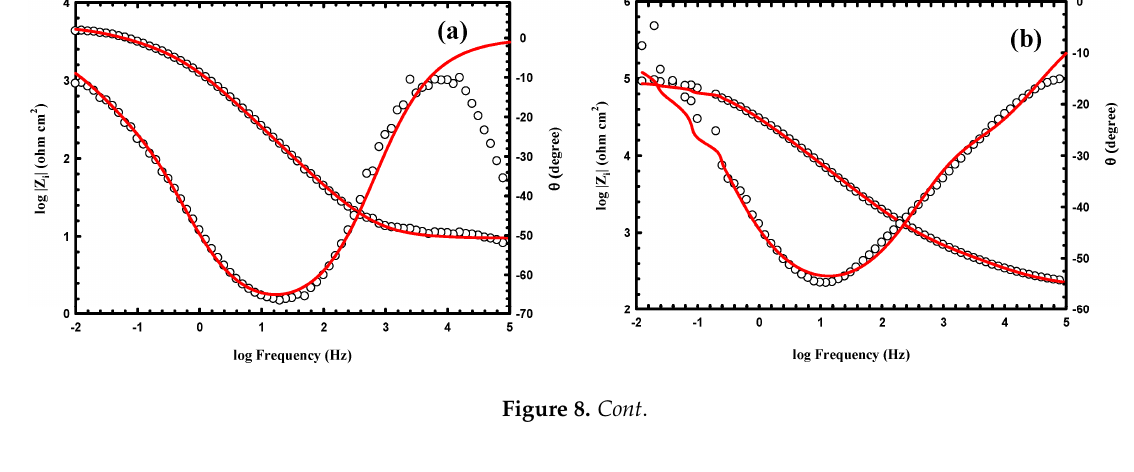
Figure 8. Cont Figure 8. Cont.